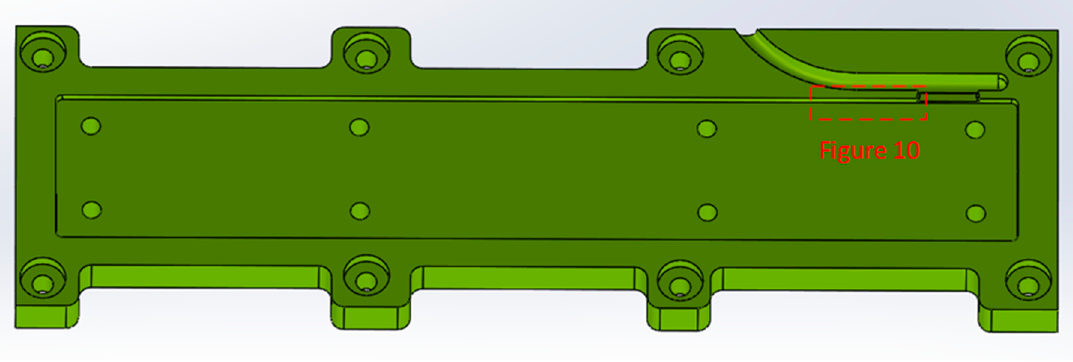
Figure 3. Solid model of the cavity insert used for printing.